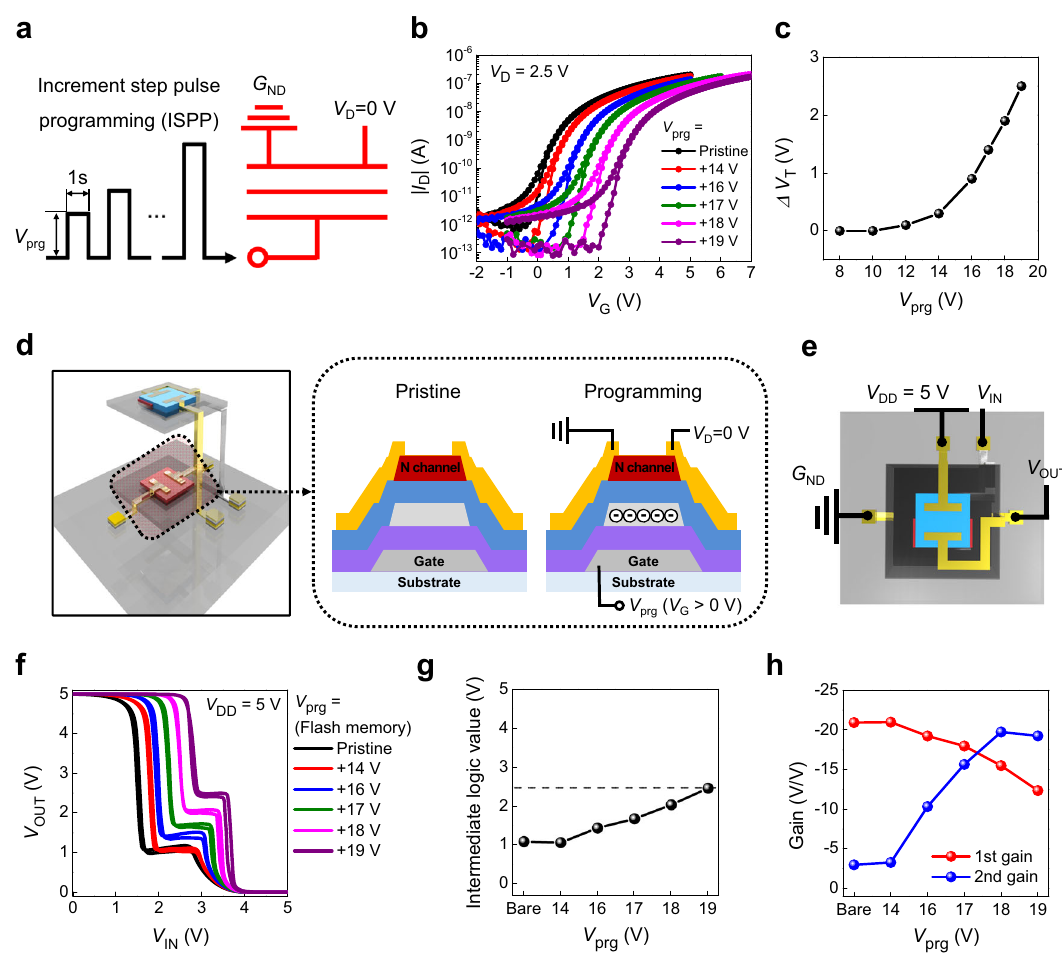
Fig. 4 The 3-dimensional (3D) ternary logic inverter (T-inverter) performance according to the programming state of the fl ash memory. a A schematic diagram of the incremental step pulse programming (ISPP) of the fl ash memory. b The transfer characteristics of the memory and c change in threshold voltage ( V T ) with respect to a programming voltage ( V prg ). A schematic illustration of d the 3D T-inverter with different fl ash memory states and e 3D T-inverter measurement. f The voltage transfer characteristics (VTCs), g intermediate logic value, and h DC gain values according to V prg of the fl ash